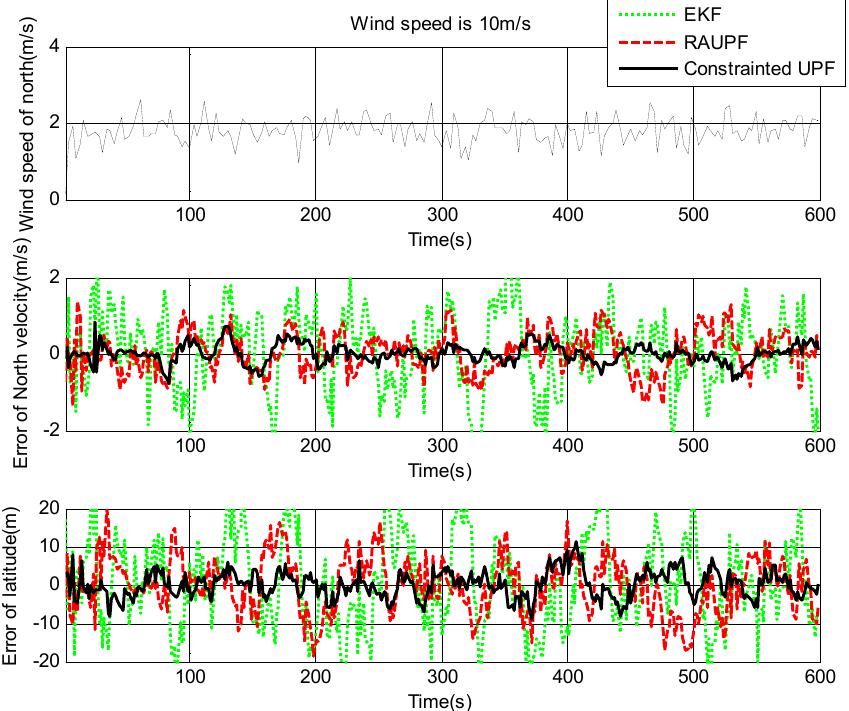
Figure 4. North velocity and latitude errors under the wind speed of 10 m/s.